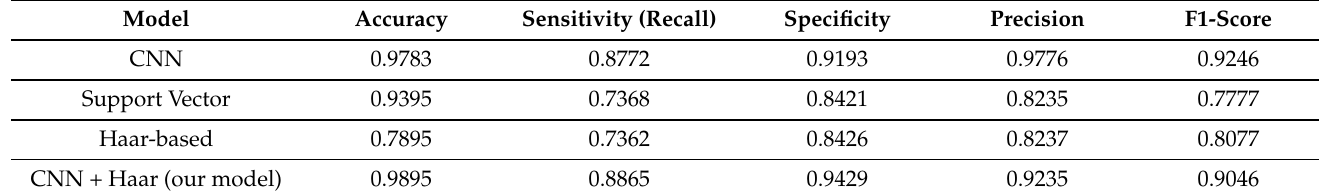
Figure 8. ROC curves for various methods of estimation and face search in images. On average, the CNN + Haar and CNN algorithms provide an increase in TPR by 0.0190 and 0.0176, respectively, in absolute terms, or by 2.7 and 3.8% in relative terms. The maximum increase in TPR was 0.0418 and 0.0394, respectively, or 3.7 and 3.8%. Haar- based algorithms, on the contrary, showed a worse result by an average of 0.0086, or 1.1%, and a maximum of 0.0183, or 2.3%. When using new approaches to train the classifier, it is possible to achieve an improvement in the quality of segmentation by up to 4% according to the TPR metric, and a reduction in FPR classification errors by up to 10%. When comparing the ROC curves, it can be seen that the CNN + Haar classifier shows results that are noticeably superior to the results of the Support Vector classifier over the entire main operating range of FPR values. The share of correct answers of CNN algorithms is 0.9783, Support Vector is 0.9395, Haar-based is 0.7895 and CNN+Haar is 0.9895 (Table 5). Efficiency of CNN model identification, Support Vector, Haar-based models, CNN + Haar